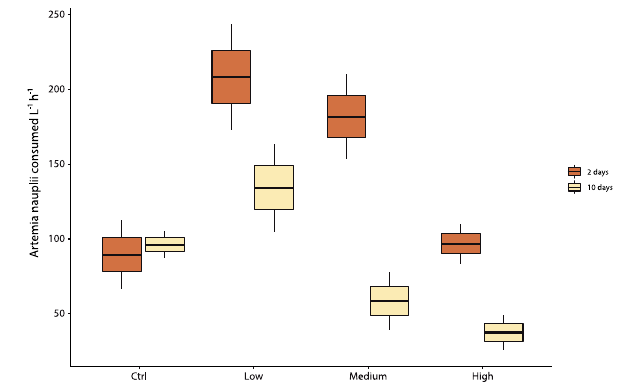
Fig. 1 Feeding rates of C. rubrum exposed to microplastics. Reported are data obtained by coral branches exposed to different concentrations of microplastics (low, medium and high) and fed with nauplii of A. salina after 2 and 10 days of experiment. Data are represented as mean ± standard deviation ( n =